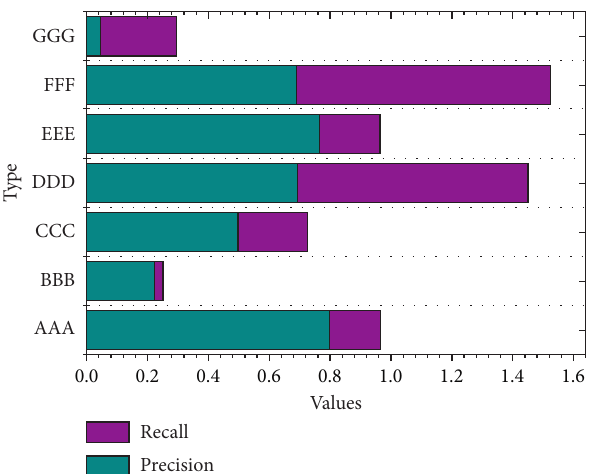
Figure 3: Plot of the total number of trustworthy compliments with distance decay parameter.